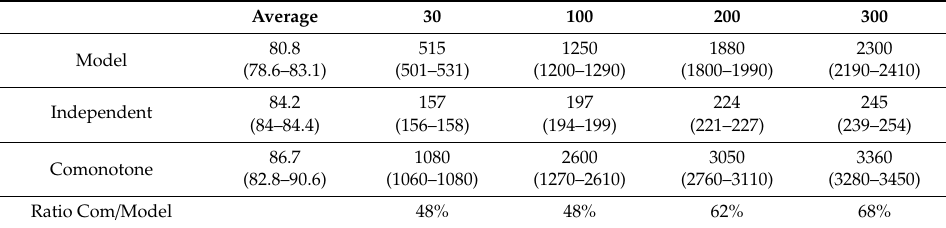
and ˆ F − 1 is the inverse of the empirical distribution function, cf. [47] for a motivation of this formula, where we approximate the binomial distribution by a normal distribution. Note that the resulting confidence interval is not necessarily symmetric around the